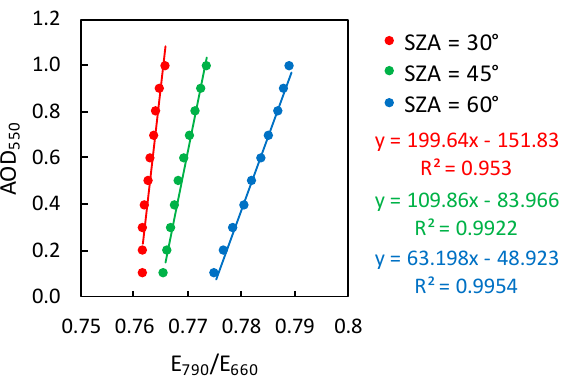
Figure 2. The relationship between AOD 550 and the ratio of the irradiance at 790 nm to that at 660 nm (E 790 /E 660 ) based on the MODTRAN simulations for different solar zenith angles.